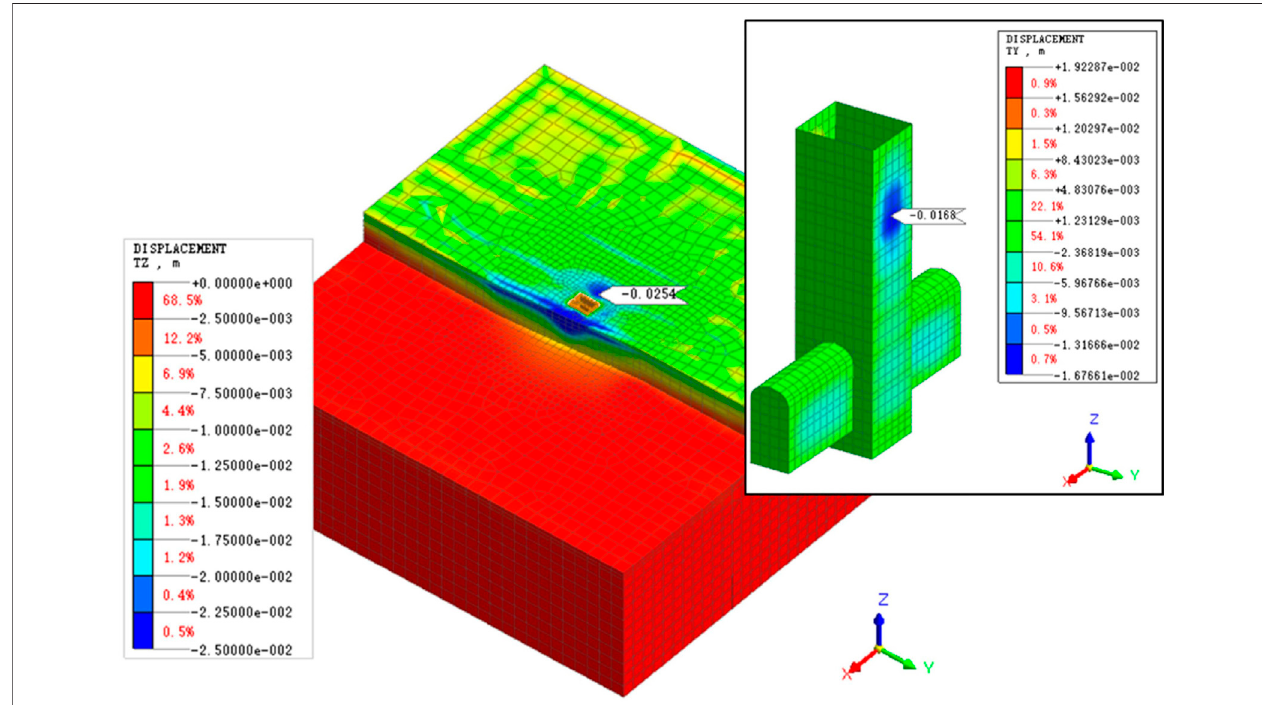
FIGURE 10 | 3D fi nite element model displacement